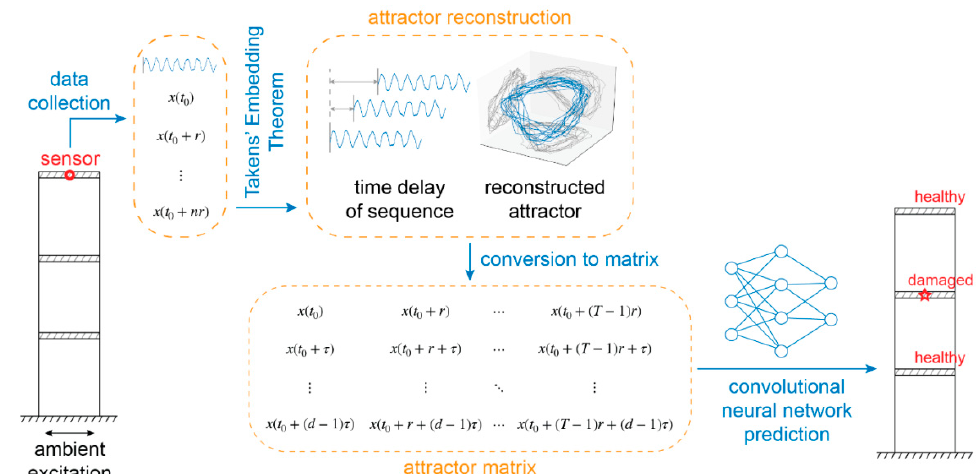
Figure 1. Classification scheme. Data collected from a single sensor from the structure is converted into a matrix based on Takens’ embedding theorem. The matrix is then fed into a convolutional neural network for feature extraction and classification of the underlying structure’s level of structural damage and for determining the location of damage.